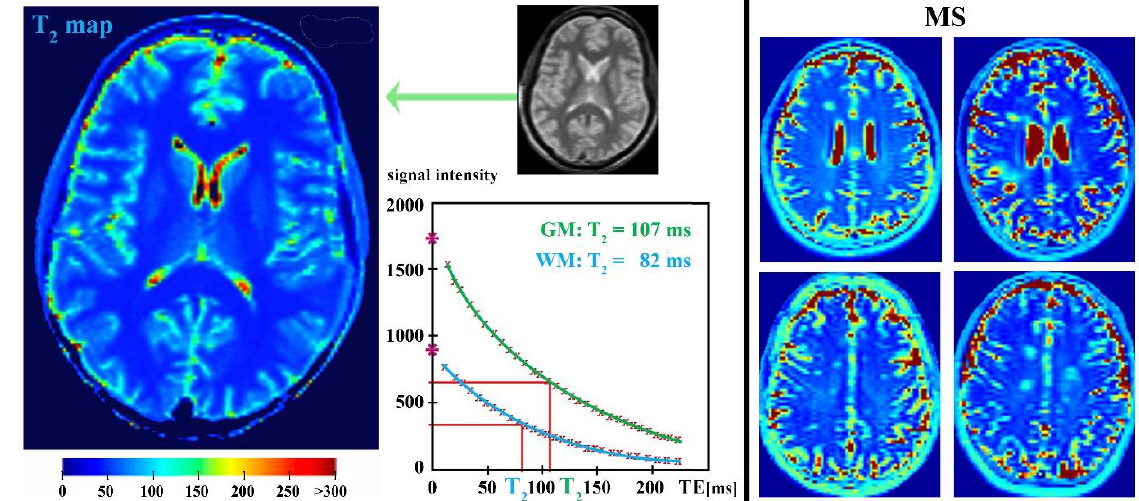
Figure 6. Visualization of the T 2 relaxation time mapping. T 2 relaxation time mapping of the brain tissue showing measured relaxation signal decays (relaxation curves, blue for white matter (WM) and green for gray matter (GM)), including relaxation T 2 time values for both WM and GM. The T 2 parameter maps for healthy (on the left) and MS-affected (on the right) brain are also depicted.